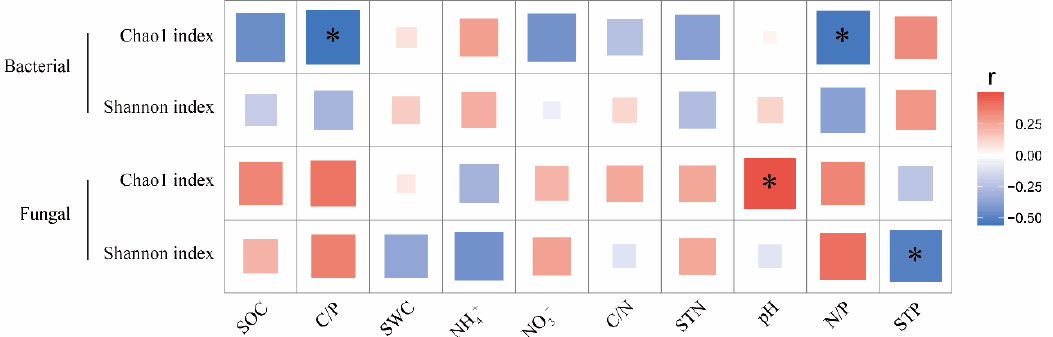
Figure A1. Observed species rarefaction curves of the bacteria ( a ) and fungi ( b ) under different treatments.